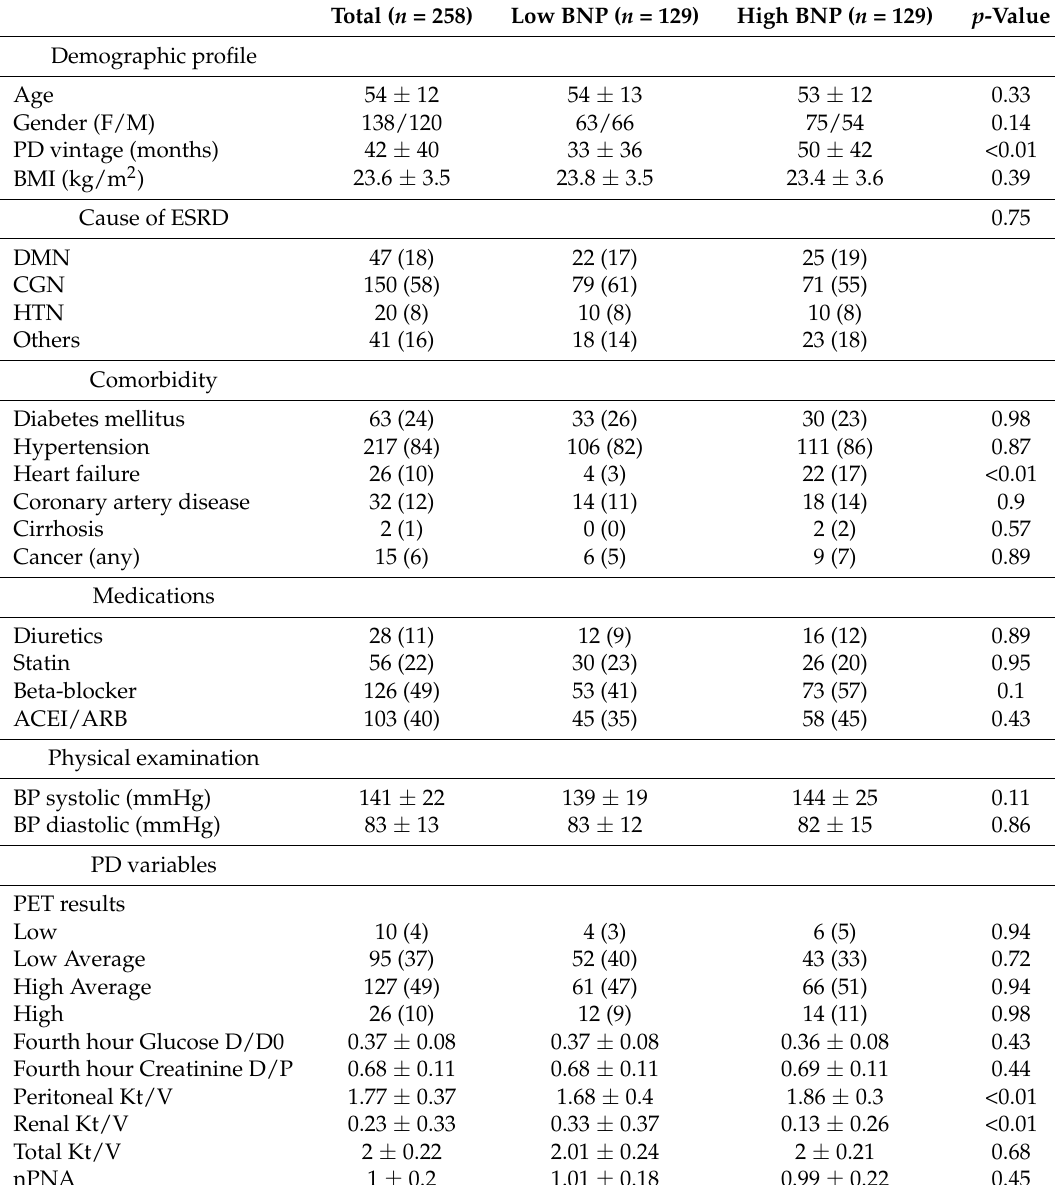
Table 1. Comparison of clinical characteristics between PD patients with low and high BNP